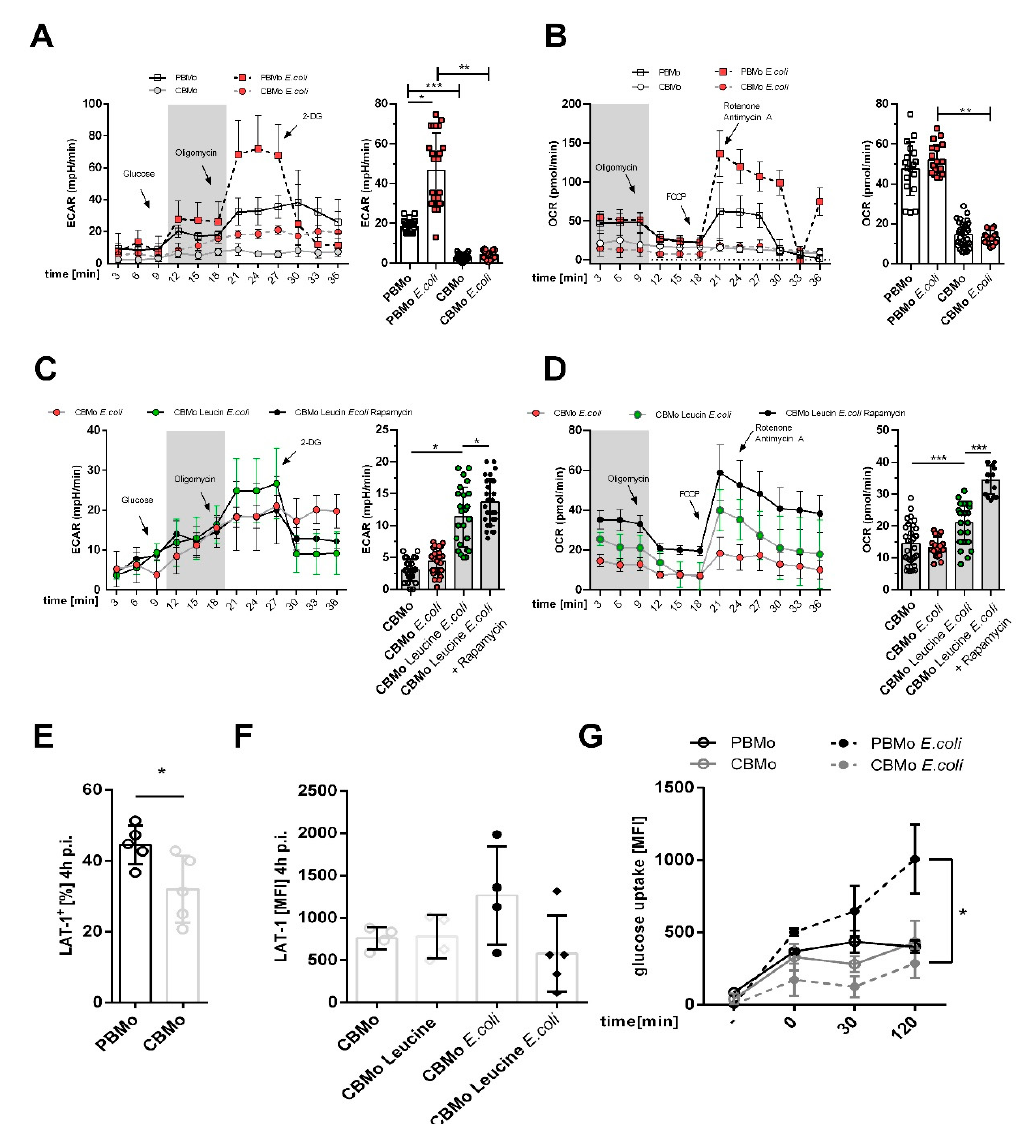
Figure 1. Energy metabolism in Mo. Extracellular acidification rate (ECAR) profile of indicated groups ( A , error bars give standard deviation (SD)). The comparative summary of basal glycolysis (grey area in A ) is given in the chart to the right. OCR (oxygen consumption rate) profile of indicated groups ( B , error bars give SD). The chart to the right summarizes the basal respiration (grey area in B ; bars, Student’s- t -test, * p < 0.05; blunt ended bars, ANOVA analysis; ** p < 0.01; *** p < 0.005). ECAR chart ( C , error bars give SD) and OCR chart ( D , error bars give SD) compares infected CBMo. Indicated groups received leucine and rapamycin, respectively. The comparative summary of basal glycolysis (grey area in C ) and basal respiration (grey area in D ) is given in the charts to the right (error bars represent SD; Student’s t -test, * p < 0.05; *** p < 0.005). LAT-1 (L-amino-acid transporter 1) expression was assessed in non-treated PBMo and CBMo ( E ; ANOVA analysis; ** p < 0.01) and in CBMo after infection and leucine treatment ( F ). The glucose uptake of indicated groups was assessed within the given time interval via fluorometric detection of metabolized 2-deoxyglucose ( G ; error bars represent SD; Student’s t -test; * p < 0.05).